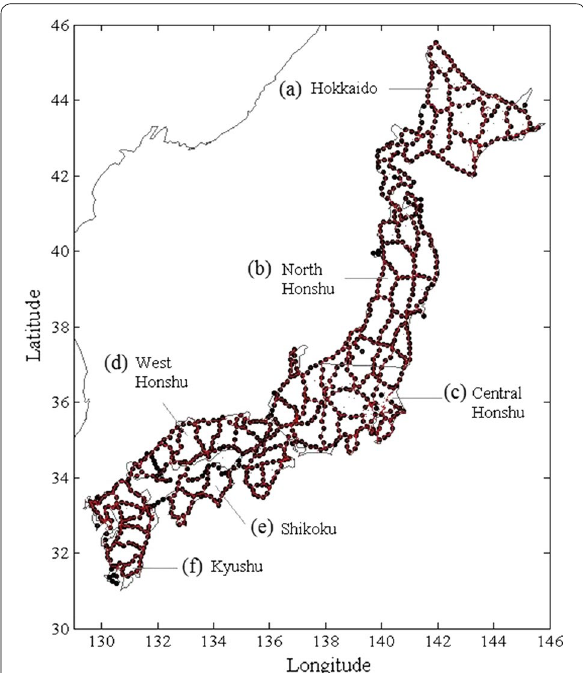
Fig. 1 Distribution of GPS/levelling (big black dots) and first-order gravity (small red dots) data over the four main islands (adapted from Odera and Fukuda